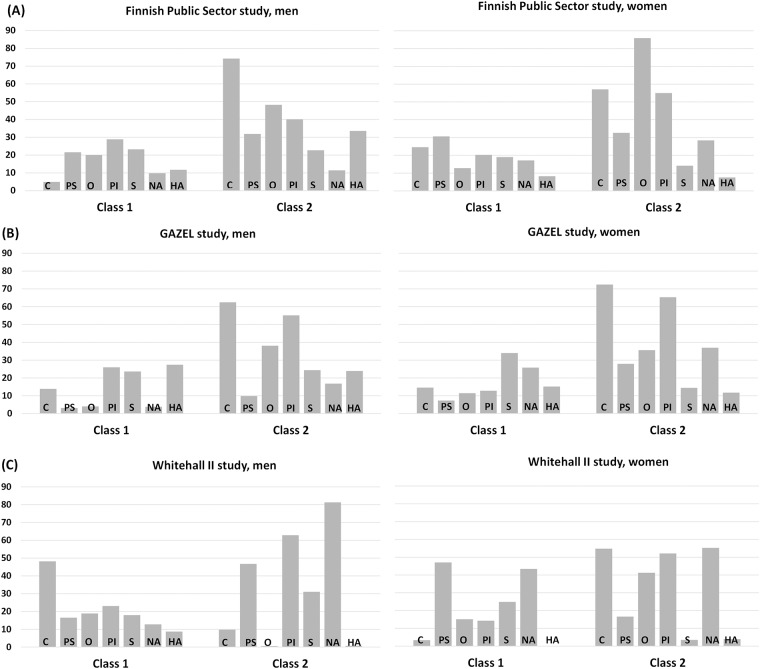
Class membership and risk factor probabilities across latent classes among men and women in each cohort (panels A to C; class 1 = ‘low-risk profile’ and class 2 = ‘high-risk profile’).Footnote: C = Comorbid somatic disease; PS = Psychological symptoms; O = Obesity; PI = Physical inactivity; S = Smoking; NA = No alcohol use; HA = High alcohol use.